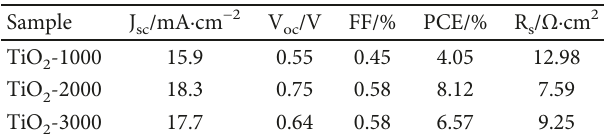
fi lm prepared with 2000rpm. (b) J-V characteristics of devices based on various c-TiO 2 Table 1: Photovoltaic performance parameters extracted from reversed J-V curves (Figure